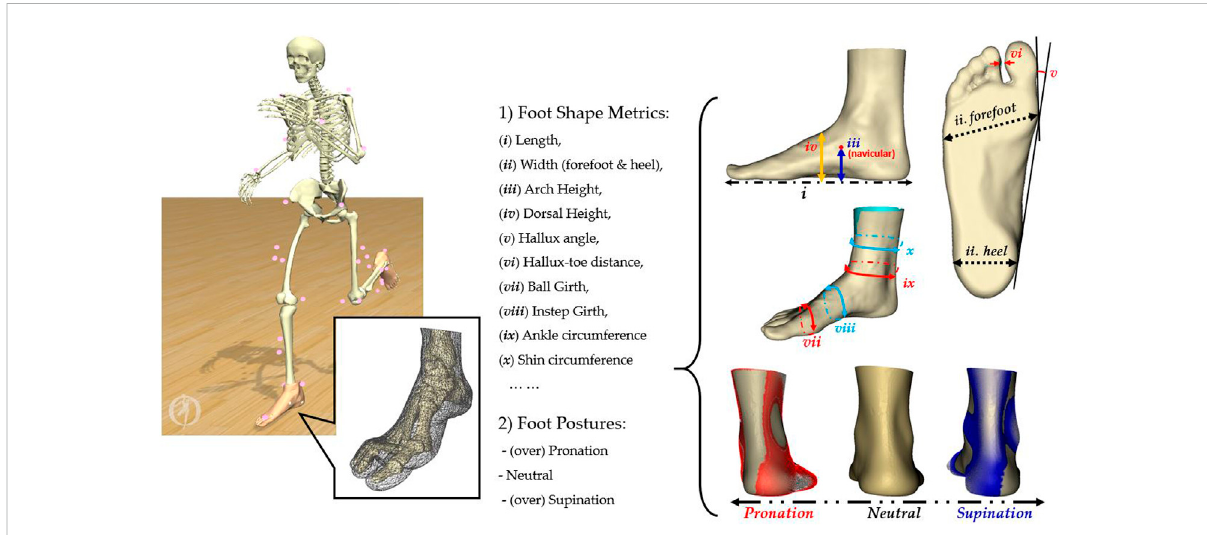
FIGURE 1 Anillustrationofpopularfootshapemetricsandfootpostureswithhighlightedvariationofpronation(redregions)andsupination(blueregions) from the posterior view.